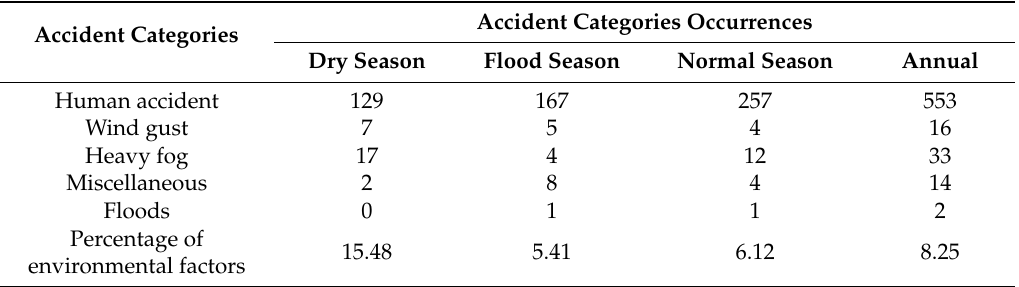
Table 1. Categories of shipping accidents during